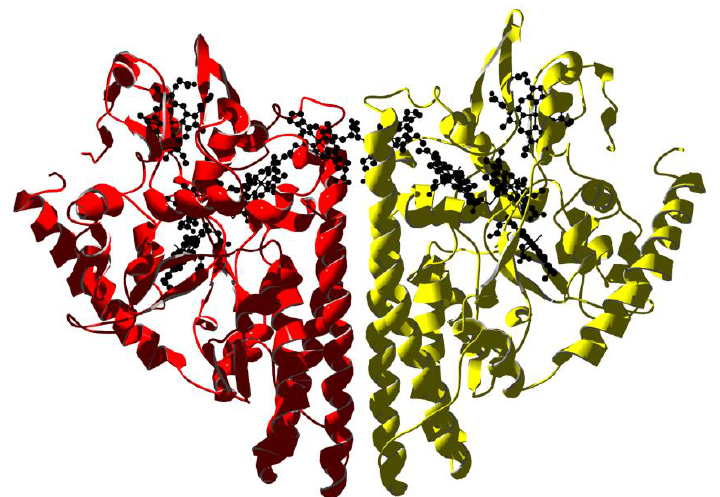
Figure 4. X-ray structure of the periplasmic pentaheme cytochrome c nitrite reductase from E. coli (PDB ID 1GU6 [131]). The homodimer is rendered with subunits in yellow and red. Heme molecules are in